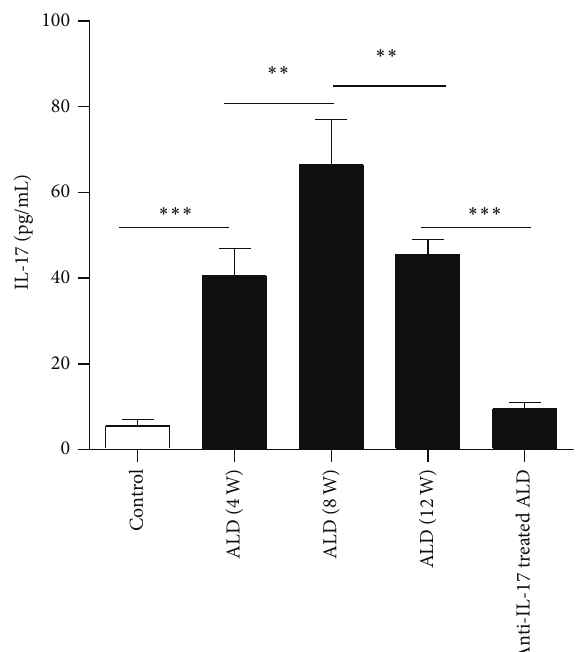
Figure2:SerumIL-17levelsasdeterminedbyELISAinthedifferent stages of ALD. (a) Control group, (b) ALD (4W) group, (c) ALD (8W) group, (d) ALD (12W) group, and (e) Anti-IL-17 antibody treated ALD group. The data indicate Mean ± SEM of three separate experiments. ∗∗ 𝑃 < 0.01 ; ∗∗∗ 𝑃 < 0.001